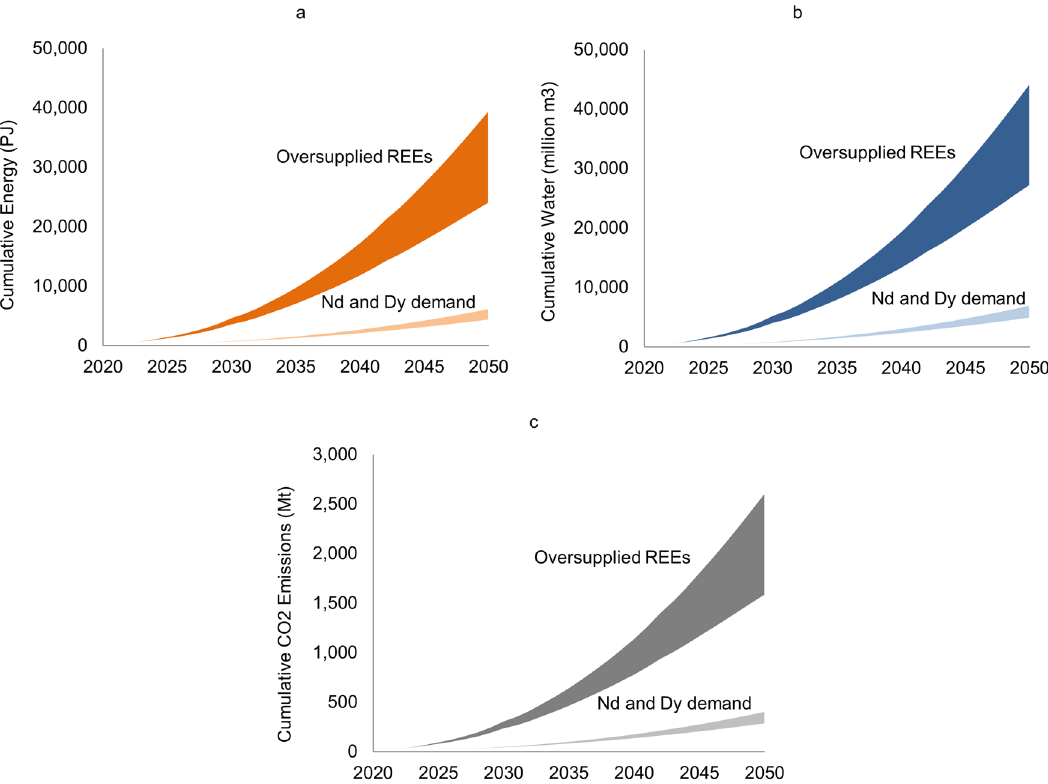
Fig. 5 Energy, water, and CO 2 emissions associated with Nd and Dy production and oversupplied REEs. Cumulative a energy, b water, and c CO 2 emissions associated with the production of Nd and Dy required for the two technologies and the oversupplied REEs in the high and low demand scenarios as a result of Dy demand based on the average E-W-CO 2 intensities.